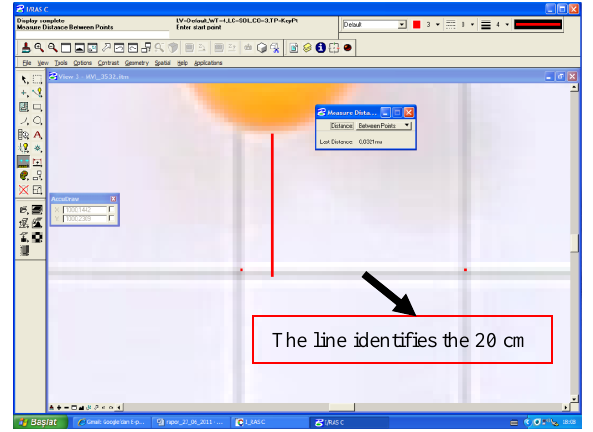
Figure 8. T he distance measuring